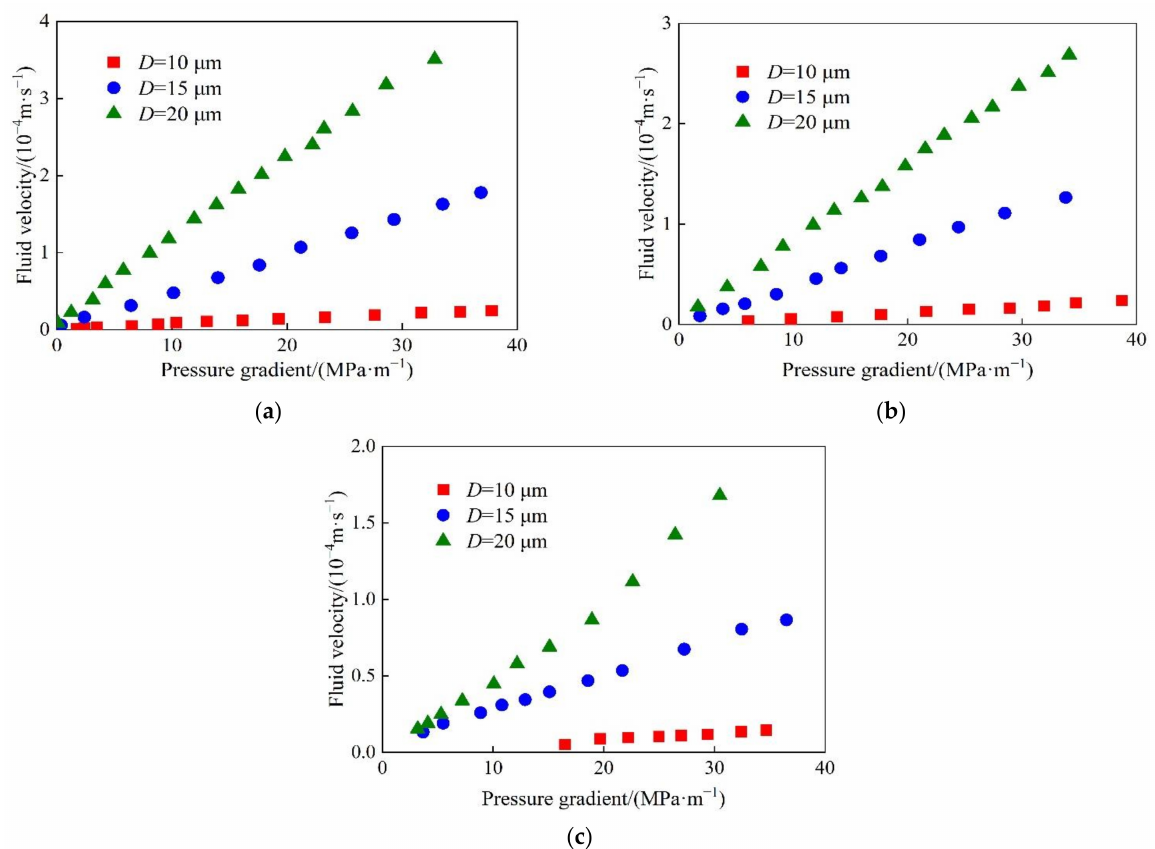
Figure 10. Flow velocity of SiO 2 /P(MBAAm- co -AM) polymeric nanoparticle solutions in different mi- crotubules versus the pressure gradient at mass concentrations of 200 ( a ), 500 ( b ), and 1000 ( c )